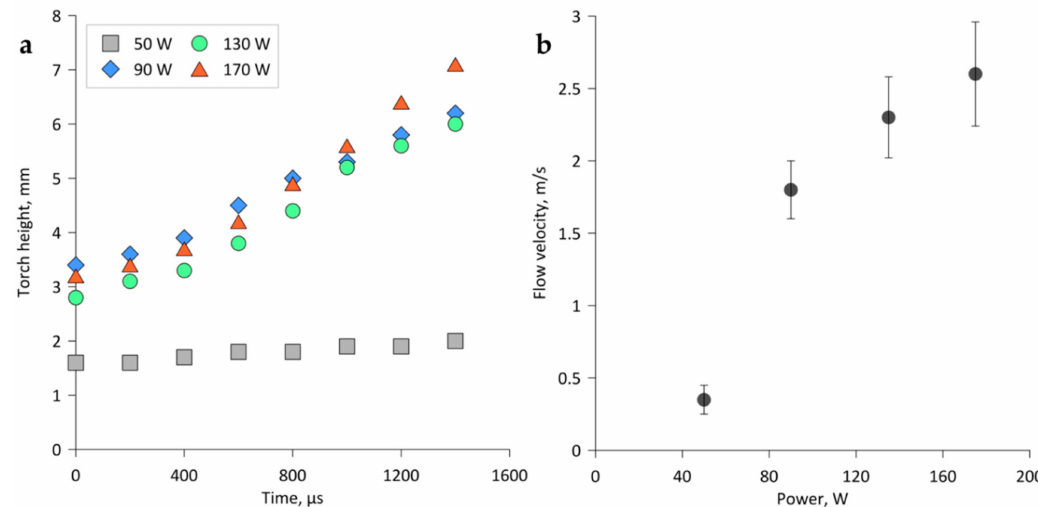
Figure 7. ( a ) The increment of plume height with time and ( b ) the calculated average velocity of the gas-phase